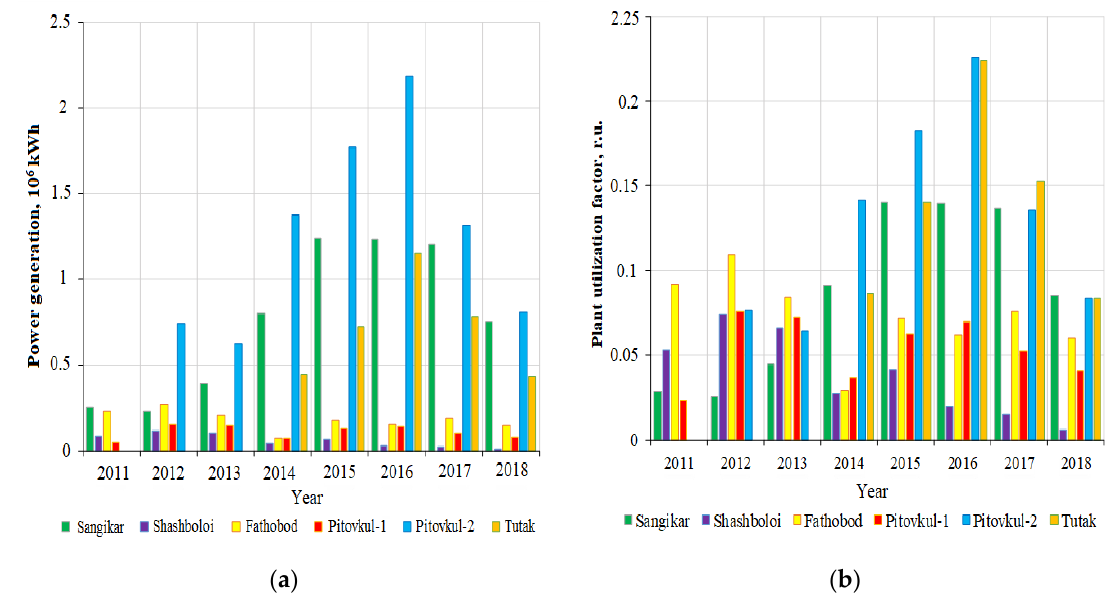
Figure 2. ( a ) The power generation and ( b ) the plant utilization factor of small-scale hydropower plants (SHPPs) in the Rasht grids.